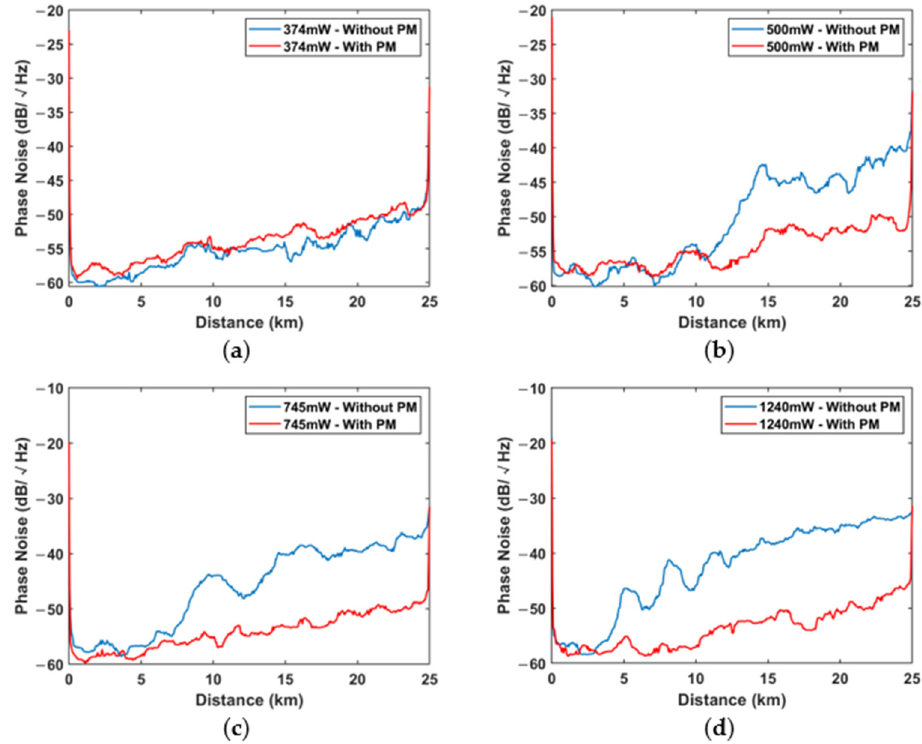
Figure 5. The evolution of phase noise along the FUT in experiment without phase modulation (blue lines) and with phase modulation (red lines): ( a ) 374 mW; ( b ) 500 mW; ( c ) 745 mW; ( d ) 1240 mW.